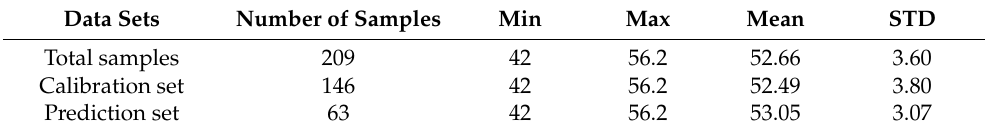
Table 5. Statistics on ABV of baijiu samples.